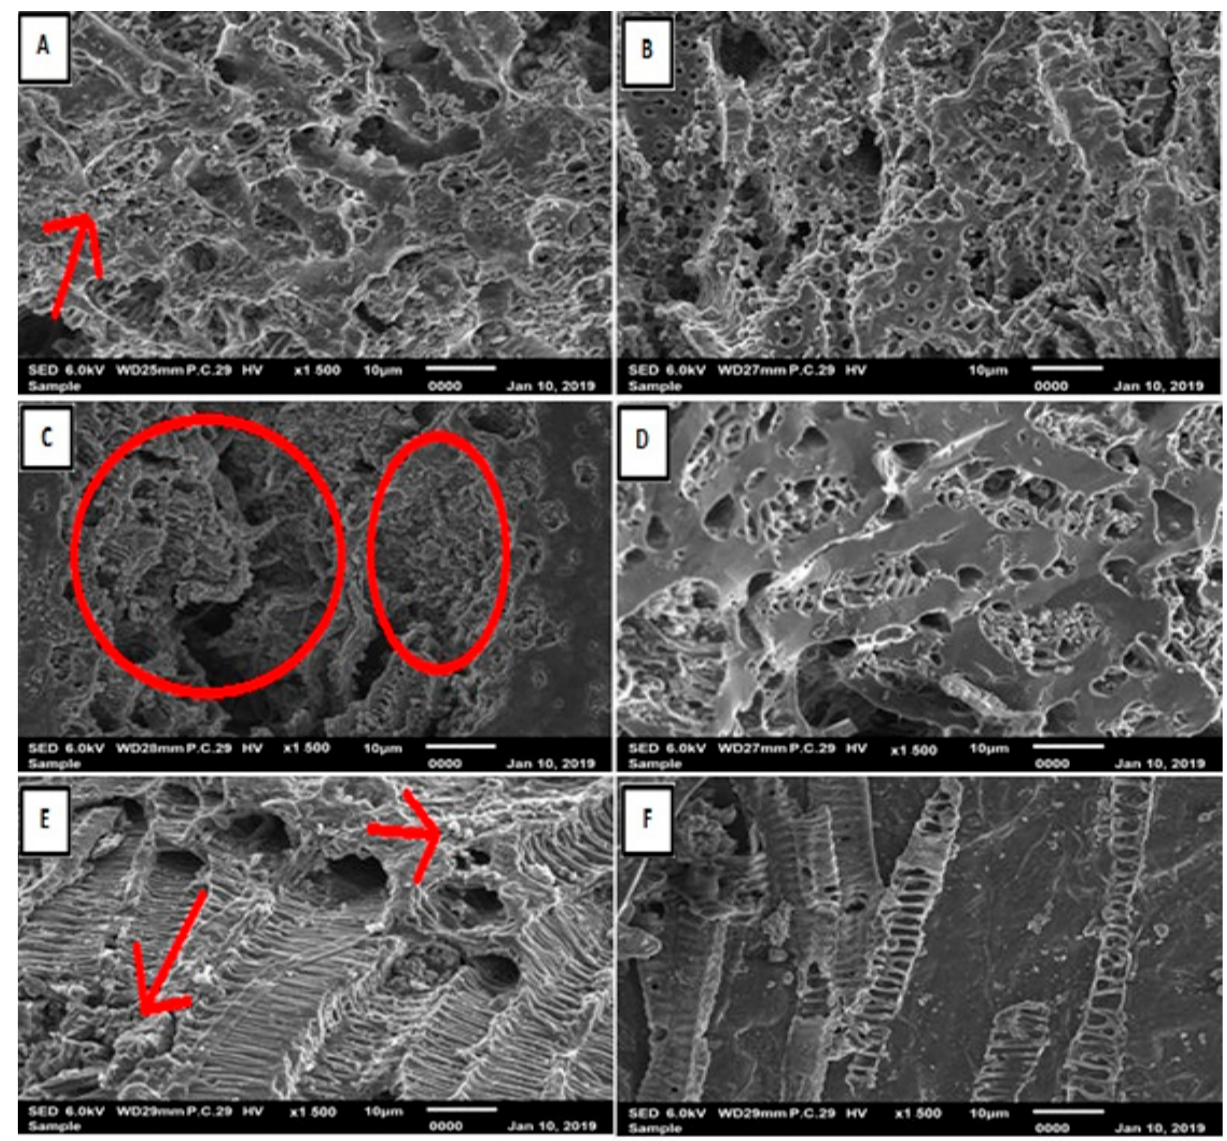
Figure 2. SEM images of an immobilizing biofilm on GAC, ( A ) biofilm for 24 h and ( B ) without biofilm at 24 h; ( C ) biofilm for 48 h and ( D ) without biofilm at 48 h; ( E ) biofilm for 72 h and ( F ) without biofilm at 72 h with T = 37 °C.